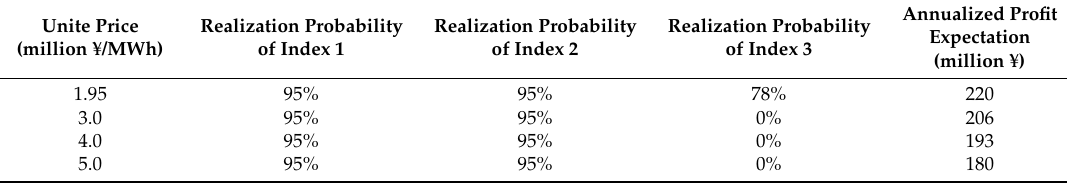
Table 3. Effects of battery unit prices on indices.